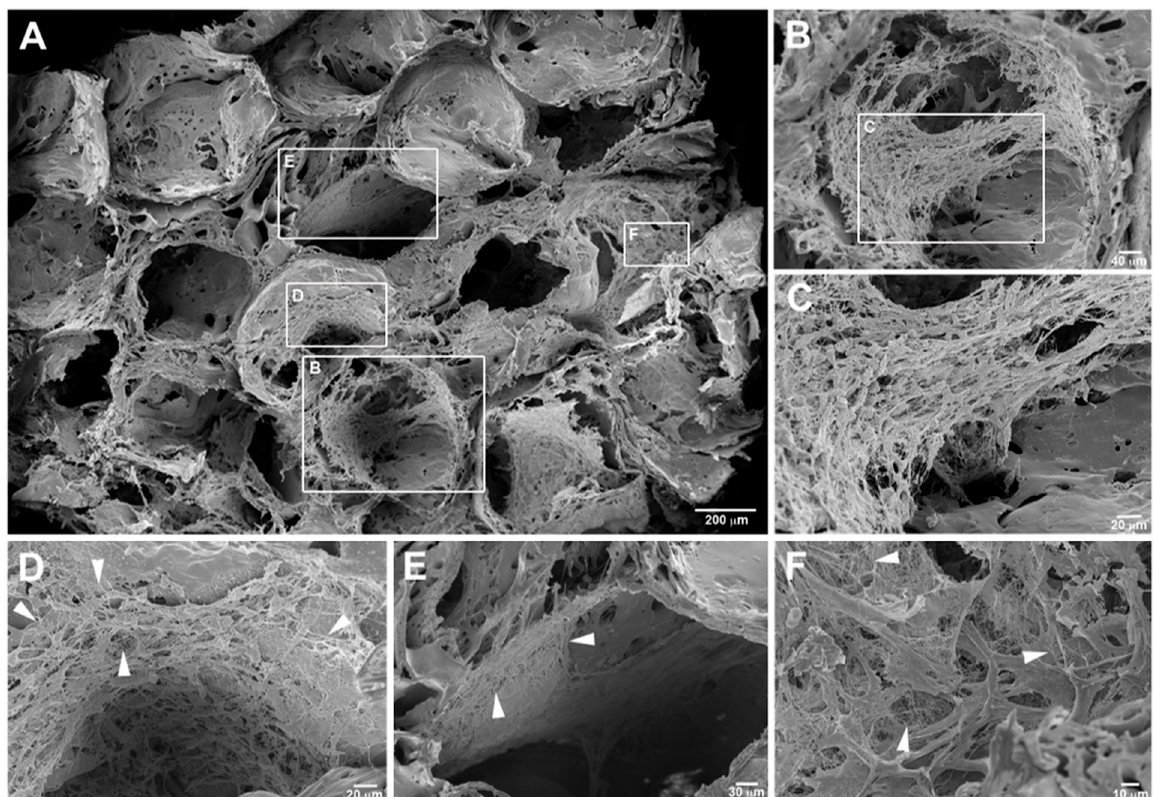
Figure 5. Silk–fibroin scaffold distribution of WJ-MSC analyzed by FE–SEM. ( A ) SSFc after 18 days of 3D culture. ( B , C ) high magnifications of the same marked area, found, respectively, in ( A , B ), showing the significant invasion ability of the cells in occupying the volume of an open space. ( D – F ) high magnifications of the same marked area in ( A ) that reveal the development of MSCs coating of the scaffold smooth surface. A significant cell–surface and cell–cell interconnectivity were shown (head arrows).